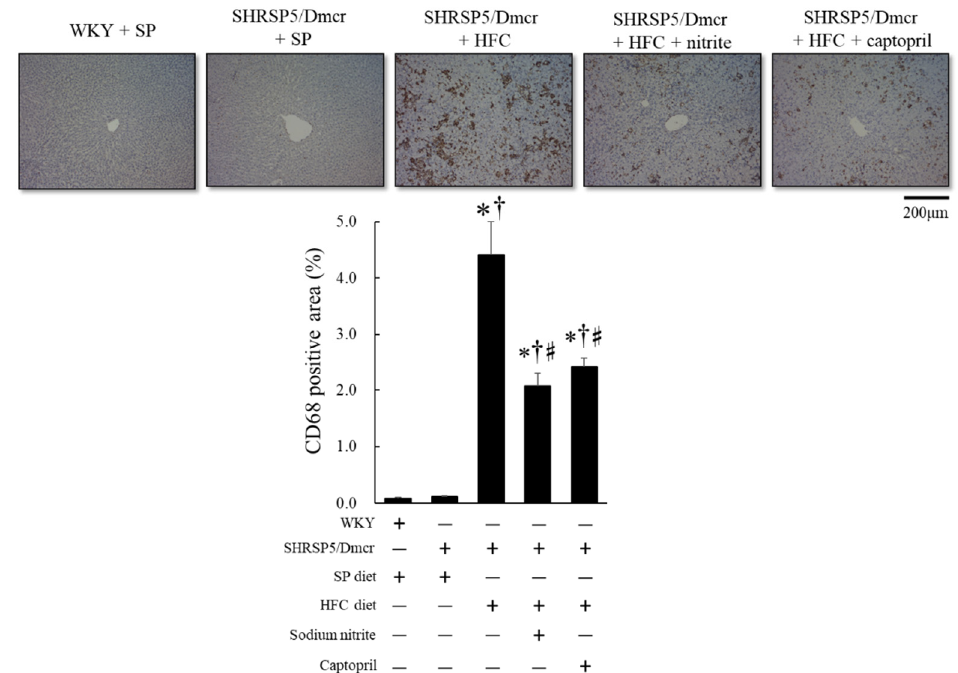
Figure 5. Immunohistochemical analysis of CD68-positive area in the hepatic tissues of the rat nonalcoholic steatohepatitis model and the effects of nitrite and captopril on the inflammatory response in the liver. Values represent mean ± SE ( n = 6), * p < 0.05 vs. WKY + SP diet group, † p < 0.05 vs. SHRSP5/Dmcr + SP diet group, (cid:93) p < 0.05 vs. SHRSP5/Dmcr + HFC diet group.